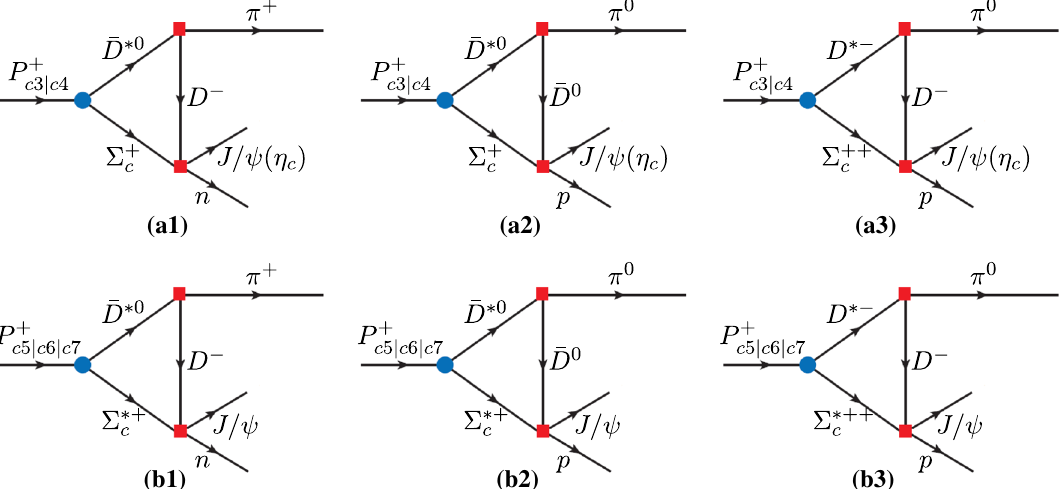
Fig. 2 Triangle-loop diagrams for the decays of P c 3 | c 4 → ¯ D ∗ (cid:2) c → J /ψ(η c ) N π ( a ) and P c 5 | c 6 | c 7 → ¯ D ∗ (cid:2) ∗ c → J /ψ N π ( b ) via the rescattering of final